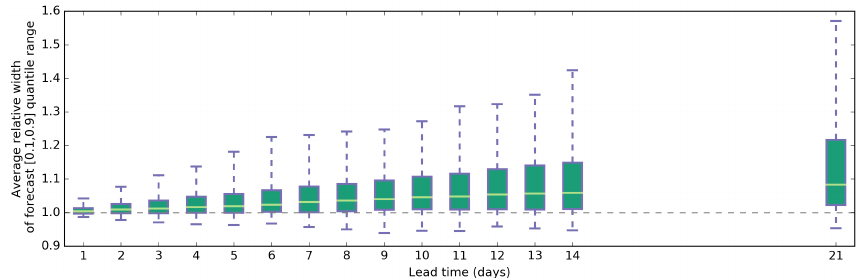
Figure 11. Box plots of the average relative width of the [0.1, 0.9] forecast quantile range of forecasts at 1–21-day lead time. The relativity is to forecasts at lead time 0. The average relative width is calculated for each forecast location and season. Cases where a forecast quantile range is 0 are